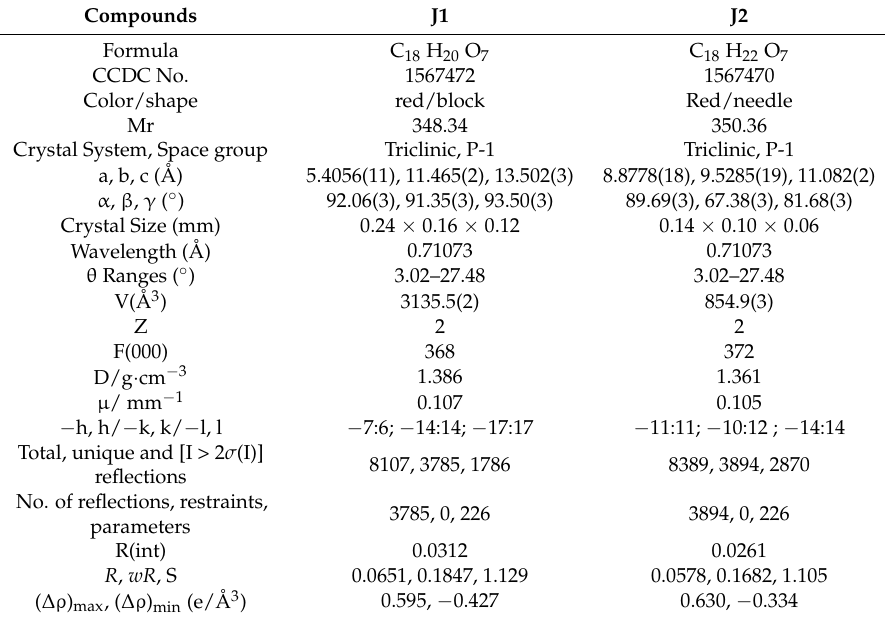
Table 1. The key parameters for J1 and J2.